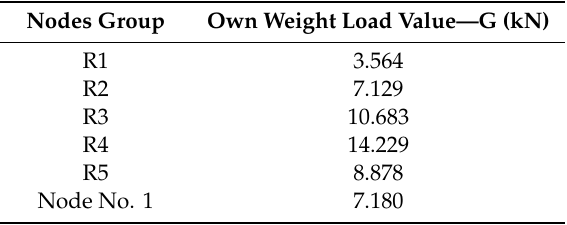
Table 4. Dome’s own weight reduced to concentrated forces at the